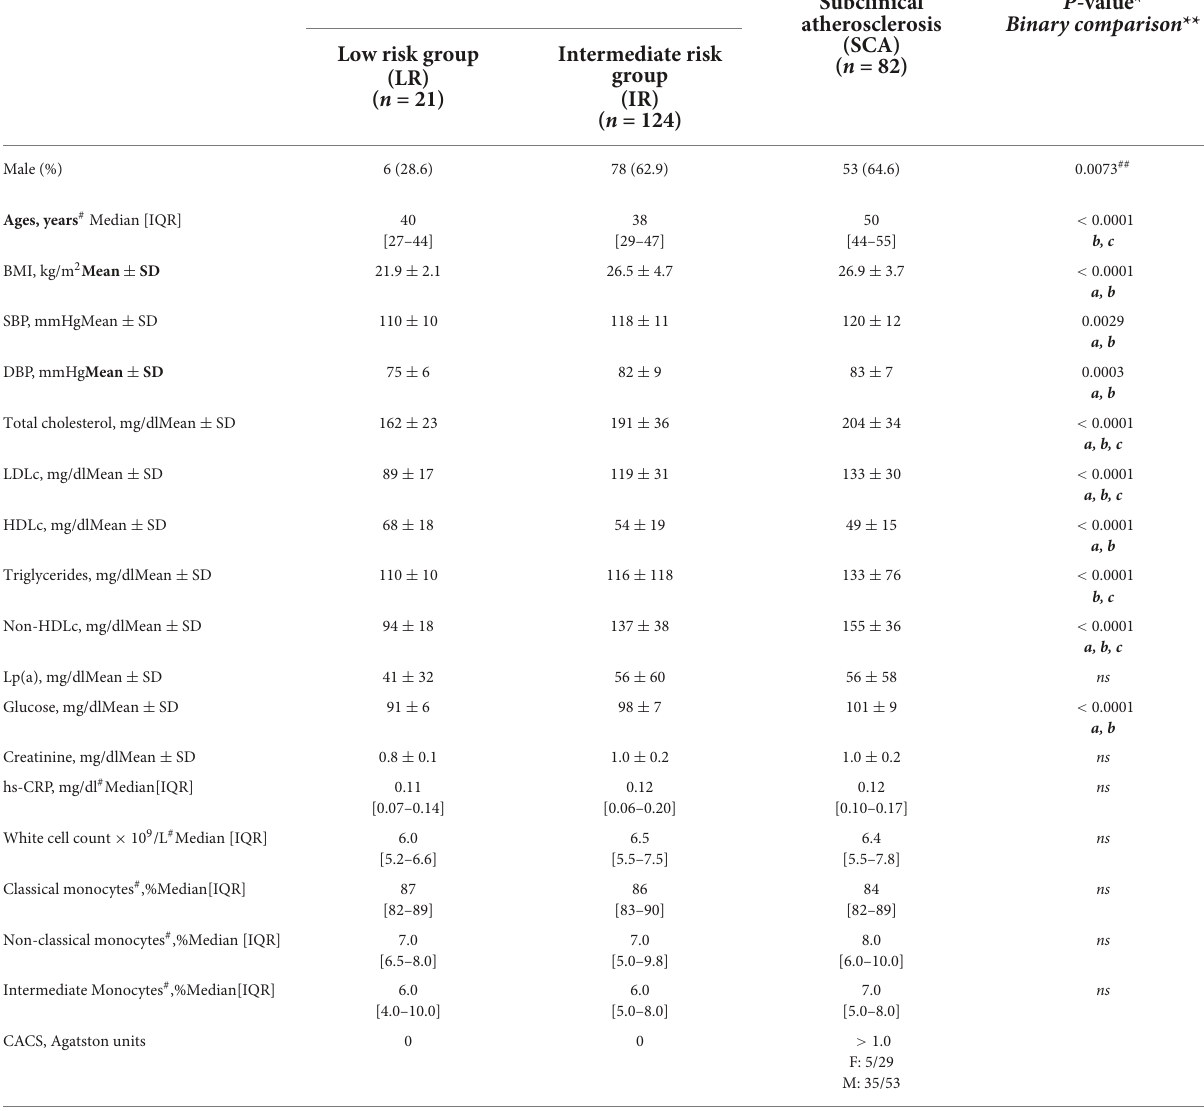
TABLE 1 Clinical and biochemical parameters (Study I). Parameters Without subclinical